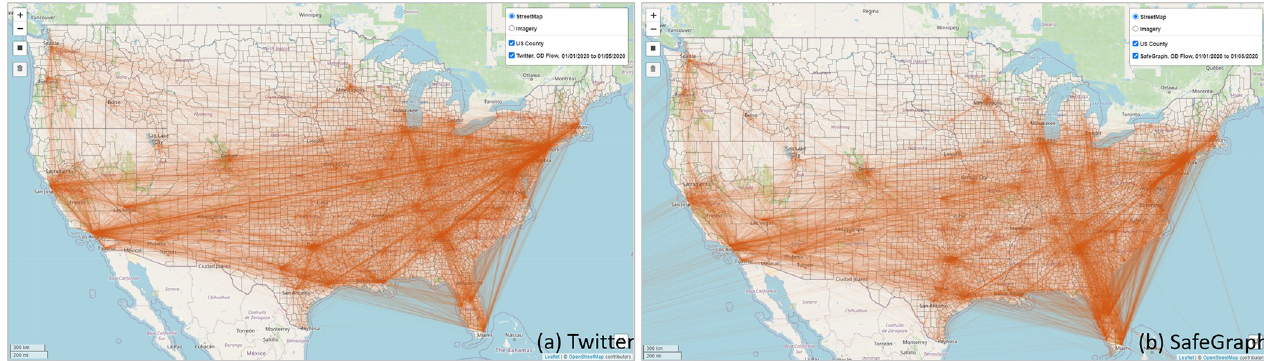
Fig 6. County-level population flows from 01/01/2020 to 01/05/2020 derived from (a) Twitter and (b) SafeGraph. Note: For SafeGraph-derived mobility data, only flows with aggregated device number great than 20 within the selected time period are displayed for performance consideration.